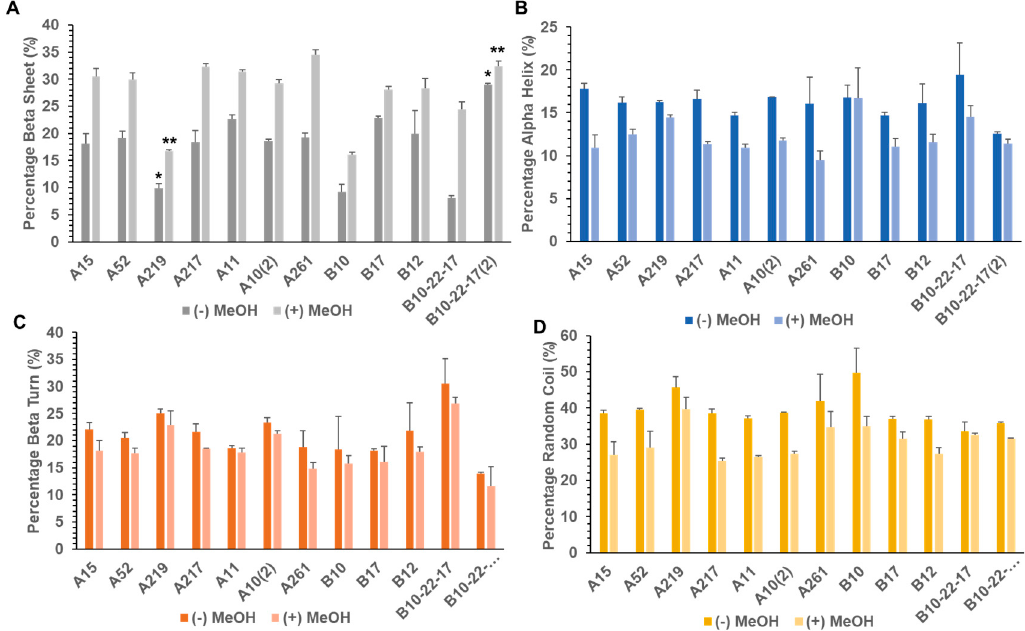
Figure 3. Secondary structure analysis of recombinant proteins in film format. Summary of percent of ( A ) β -sheet (dark gray before and light gray after methanol treatment), ( B ) α -helix (dark blue before and light blue after methanol treatment), ( C ) β -turns (dark orange before and light orange after methanol treatment) and ( D ) random coil (dark yellow before and light yellow after methanol treatment) of recombinant films. Percentage of the peak present at wavenumbers corresponding to a particular secondary structure across the amide I absorption band from 1720 to 1580 cm − 1 ( β -turns 1668–1696 cm − 1 , α -helix 1658–1667 cm − 1 , random coil 1630–1657 cm − 1 and β -sheet 1618–1629 cm − 1 and